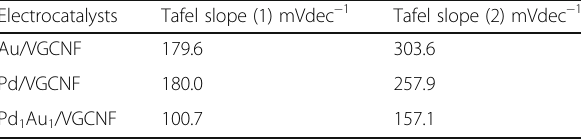
Table 4 Two different Tafel slope values on different potential oxidation